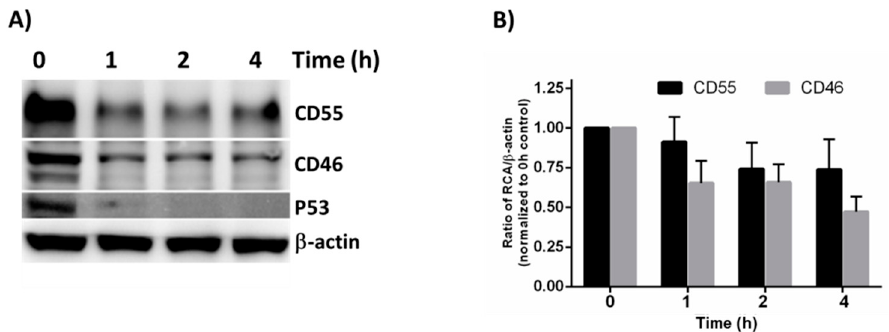
Figure 4. Cycloheximide chase assay to measure protein stability. ( A ) The HeLa cells were treated with Cycloheximide for the indicated times, and the whole cell lysate was subjected to immunoblot- ting in order to determine the stability of CD55 and CD46. β -actin was used as the loading control, and P53 served as the positive control. ( B ) Quantification of the immunoblot results by Image J software. The result represented is the average + SEM of four independent experiments obtained by normalizing the band intensity of the RCA against b-actin. The statistical significance was calculated using Student’s t